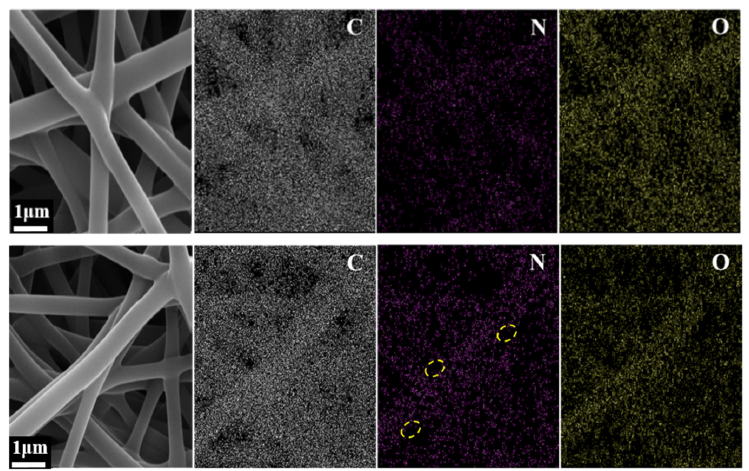
Figure 3. EDX element-distribution maps of samples VRT ( top panel) and V55 ( bottom panel).